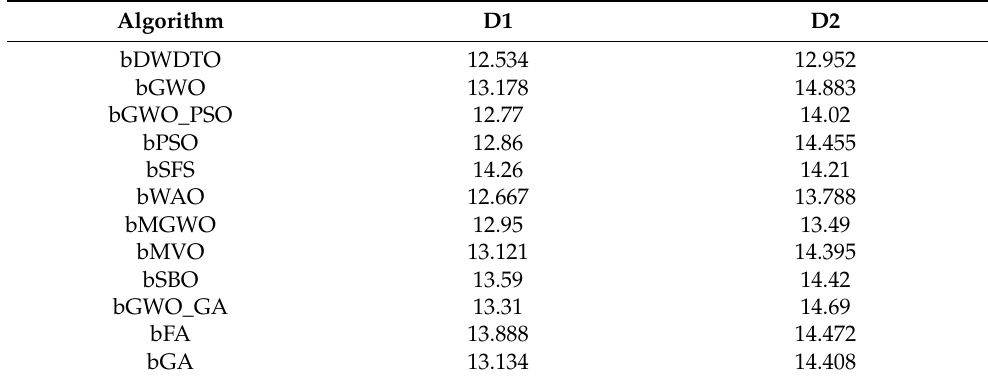
Figure 6. The convergence plot based on the proposed and other competing feature algorithms when applied to the first dataset (D1). Table 4. Time profile (in seconds) of the proposed feature selection algorithm and other algorithms.